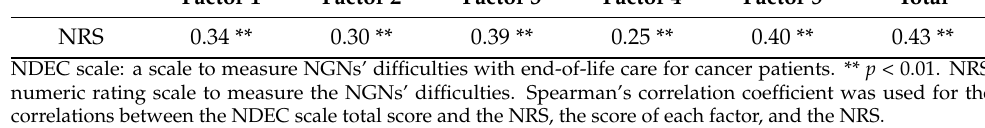
Table 4. Known-group validity of the NDEC scale.